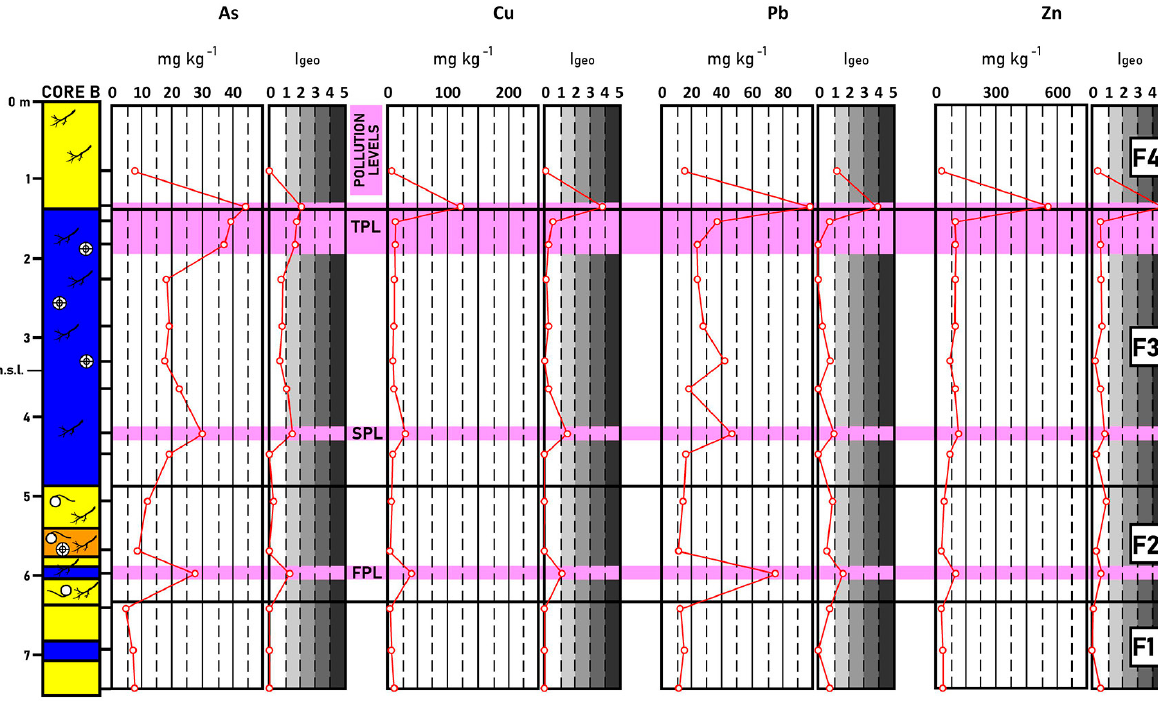
Fig. 3. – Geochemistry of core B (in mg kg –1 ). FPL: first pollution level; SPL: second pollution level; TPL: third pollution